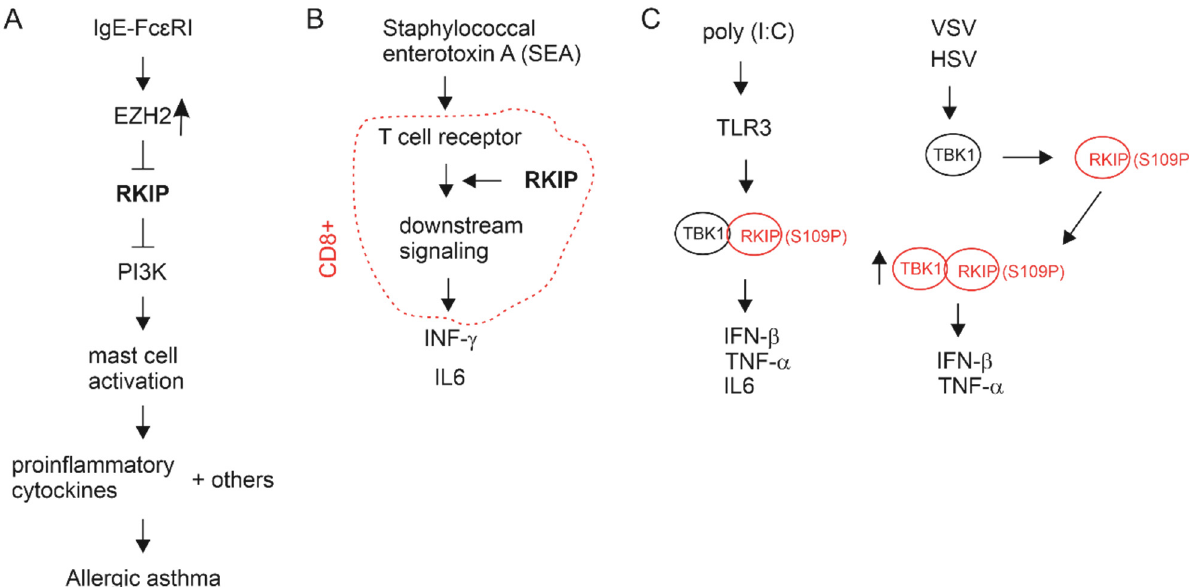
Figure 3. RKIP regulates immune reactions in vivo. The information presented here was based on literature involving RKIP transgenic mice. ( A ) Ligation of IgE to Fc ε RI on mast cell surface leads to upregulation of EZH2 that inhibits RKIP transcription. The action reduces RKIP-mediated inhibition of PI3K which promotes mast cell activation, leading to the production of proinflammatory cytokines and other factors, followed by allergic asthma [67]. ( B ) RKIP facilitates T cell receptor downstream signaling events, resulting in the production of INF- γ and IL-6 in CD8+ T cells treated with SEA [69]. ( C ) Polyinosinic:polycytidylic [poly(I:C)] activates TLR3 (Toll-like receptor 3), leading to phosphorylation of RKIP at S109 (S109P) which binds to and activates TBK1 (TANK-binding kinase 1); TBK1 promotes the production INF- γ , TNF- α , and IL-6 [71]. VSV (vesicular stomatitis virus) and HSV (herpes simplex virus) infections induce phosphorylation of RKIP at S109 by TBK1, which then binds to TBK1, facilitates TBK1 autophosphorylation, and enhances TBK1 activity which in turn contributes to INF- γ and TNF- α production